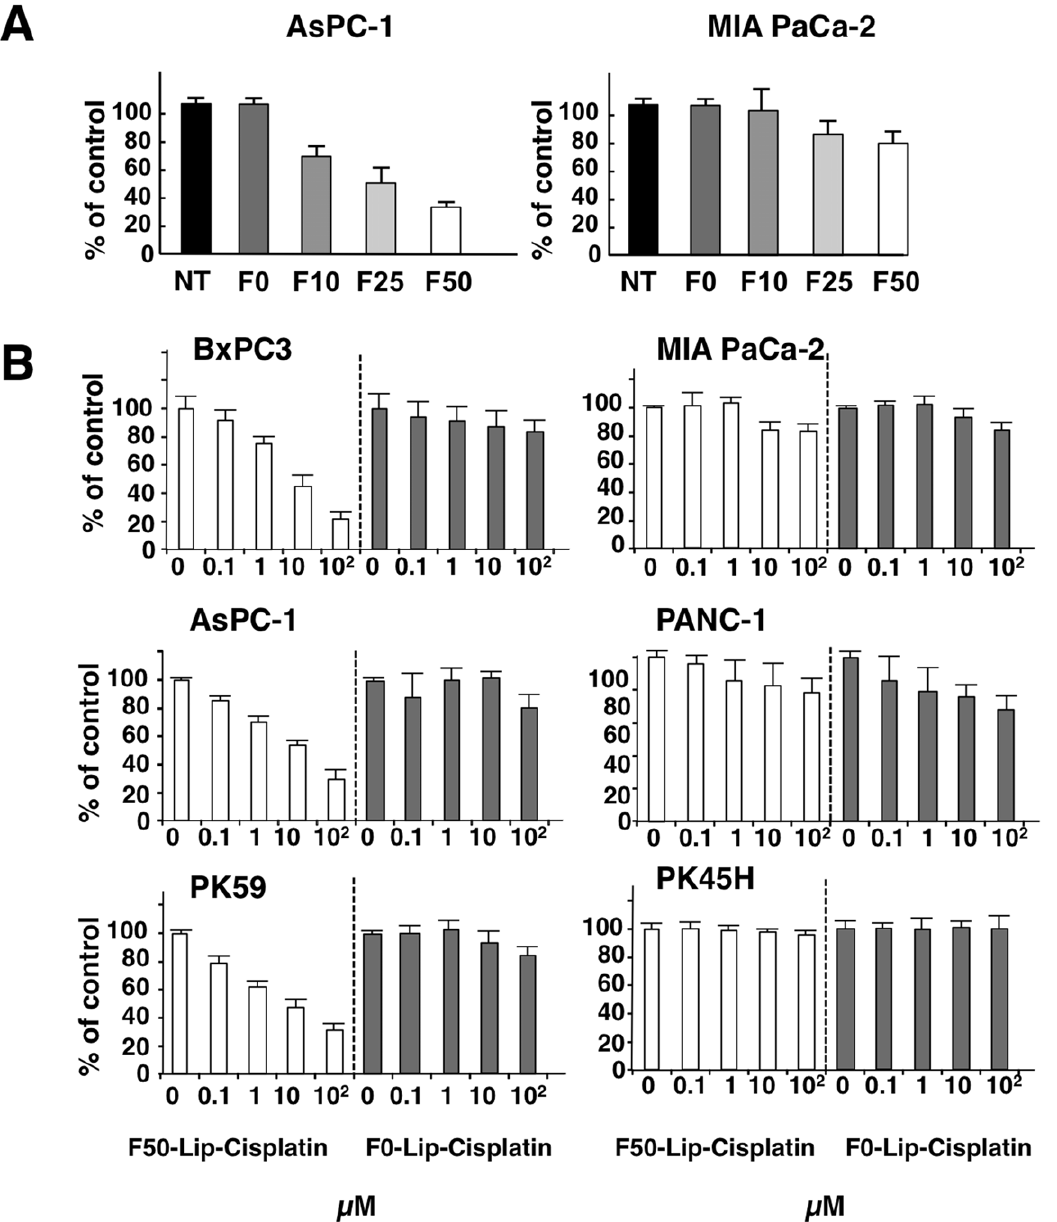
Figure 4. Effect of Fuc-Liposome-Cisplatin on the growth of pancreatic cancer cell lines. ( A, B ) Cells were treated with Fuc-Liposome containing Cisplatin for 2 hours, then washed and incubated for 72 hours. Viable cells were measured by WST assay.